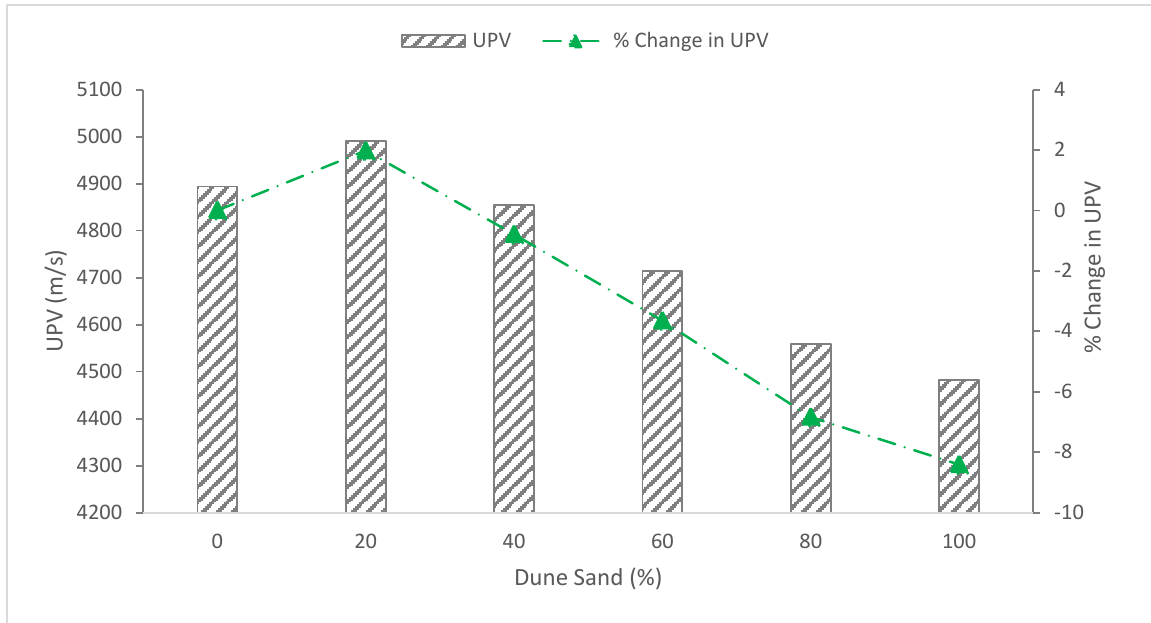
Figure 10. Water absorption: data source [40].